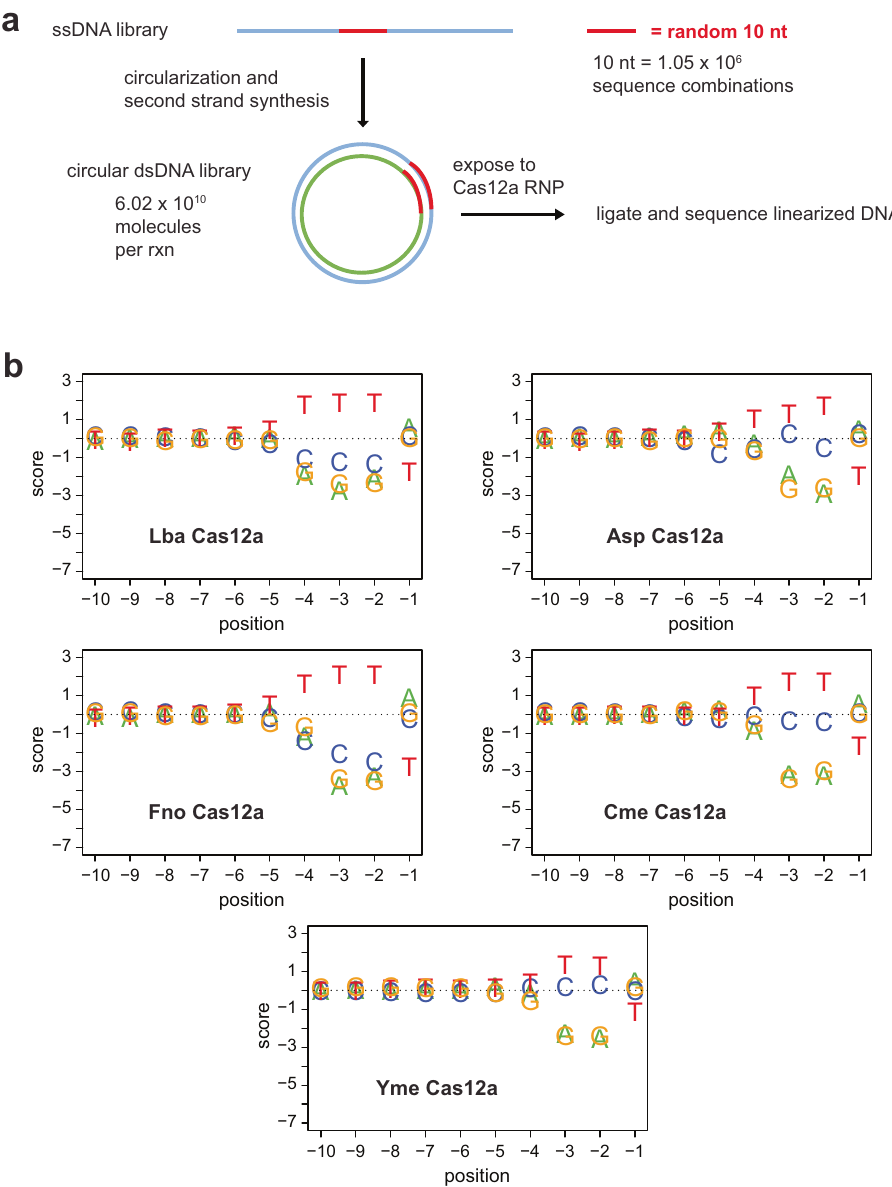
Fig. 3 PAM requirements of Cas12a orthologs. a Schematic representation of the work fl ow used to determine PAM sequence requirements for double- stranded DNA (dsDNA) cleavage. Single-stranded DNA oligonucleotide libraries with 10 nt of randomized sequence adjacent to a 20 nt target sequence were converted into dsDNA minicircle libraries and exposed to Cas12a RNPs. Linearized dsDNA libraries were subjected to end repair, adapter ligation, and sequencing. A detailed, step-wise diagram of this method is provided in Supplementary Figure S3. b PAM sequence requirements of Cas12a orthologs. Position weight values were calculated as described in the methods and are shown as graphs where a positive score corresponds to an enrichment of a particular base in the randomized 10 nt region on a log 2 scale and a negative score corresponds to depletion. The position is the distance in nt relative to the fi rst nt of the target sequence. Sequences of oligonucleotides used to make circular substrate DNAs can be found in Supplementary Data